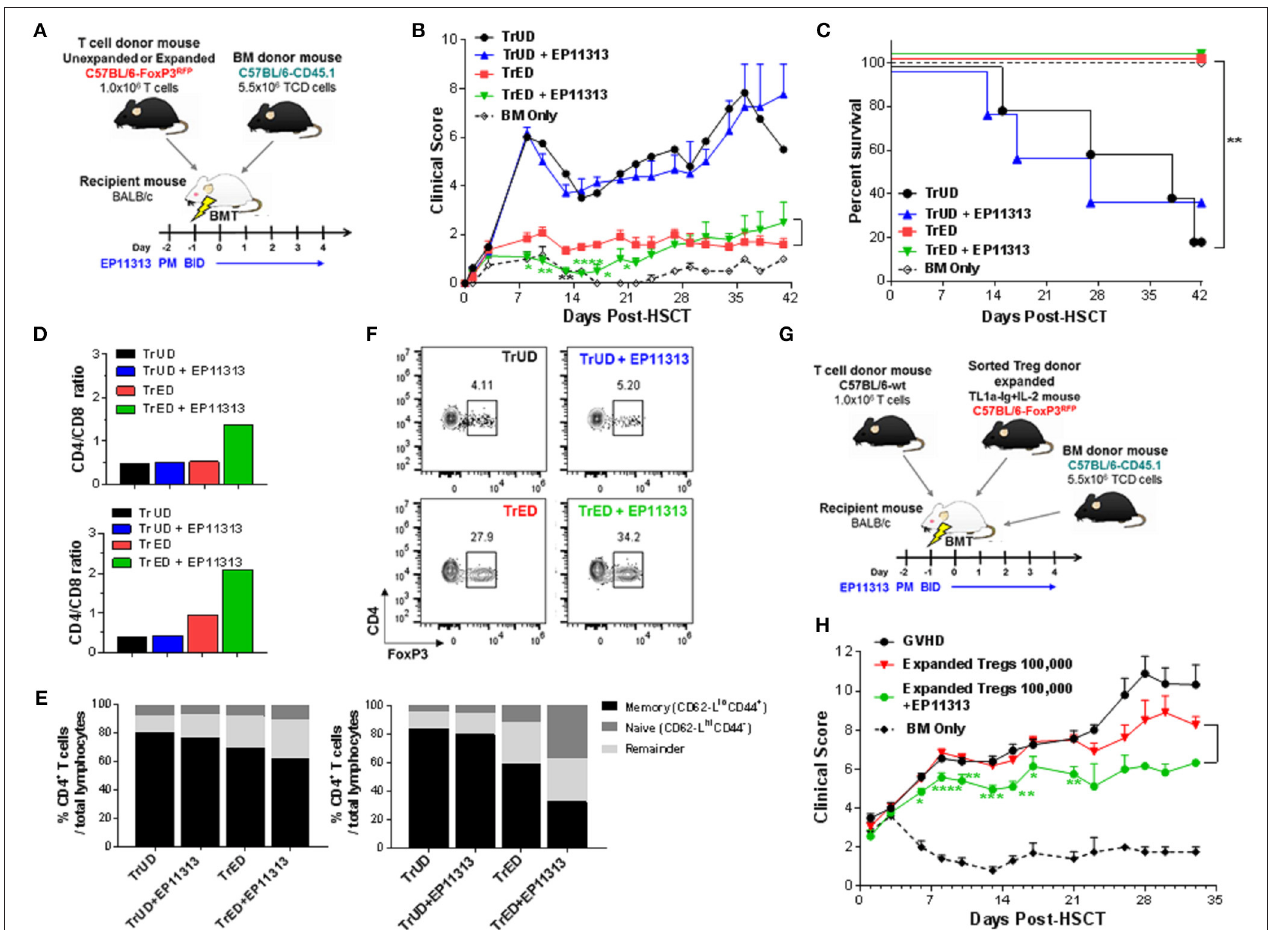
FIGURE 5 | Recipients transplanted with cells from Treg expanded donors (TrED) or low numbers of purified expanded Tregs and treated with EP11313 exhibited diminished acute GVHD after MHC-mismatched aHSCT. An HSCT was performed on Day 0 utilizing a B6 BALB/c donor/recipient mouse model involving a